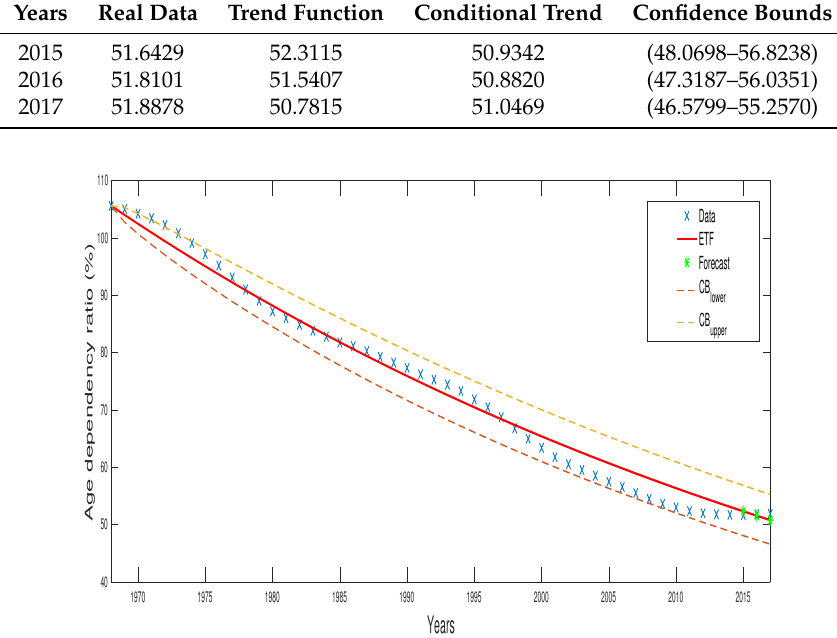
Figure 1. Observed data, estimated trend function (ETF) and the forecasted values.